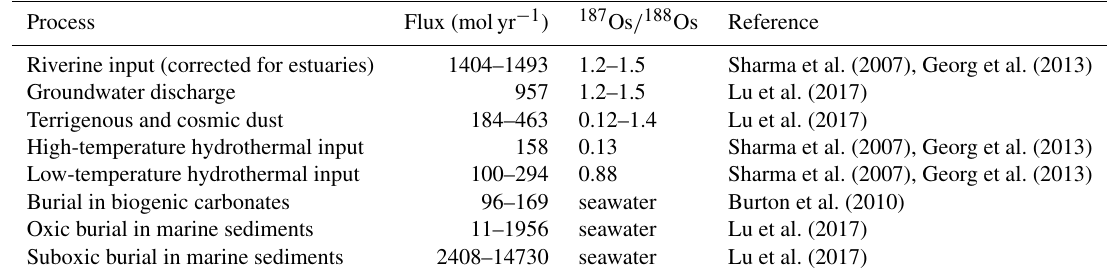
Table 2. Estimates of pre-industrial Os fluxes between surface reservoirs and their isotopic composition. In the calculation of Os burial with Ca carbonate, the estimates of Ca burial in Table 4 were